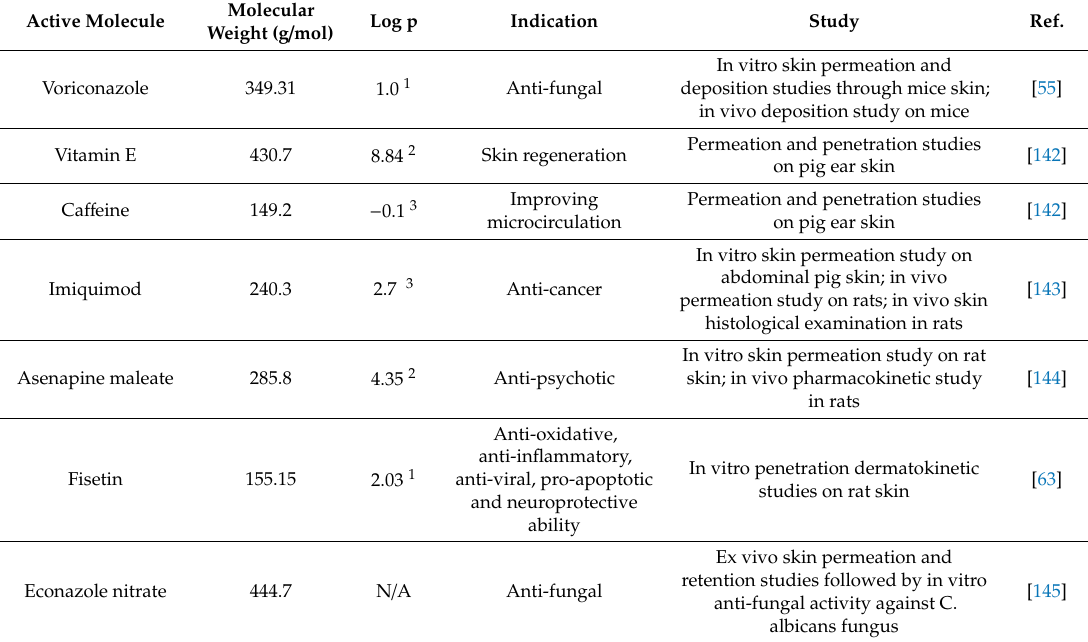
Table 4. Active molecules incorporated in transethosomes investigated for dermal / transdermal administration: in vitro and in vivo in animal studies (presented in chronological